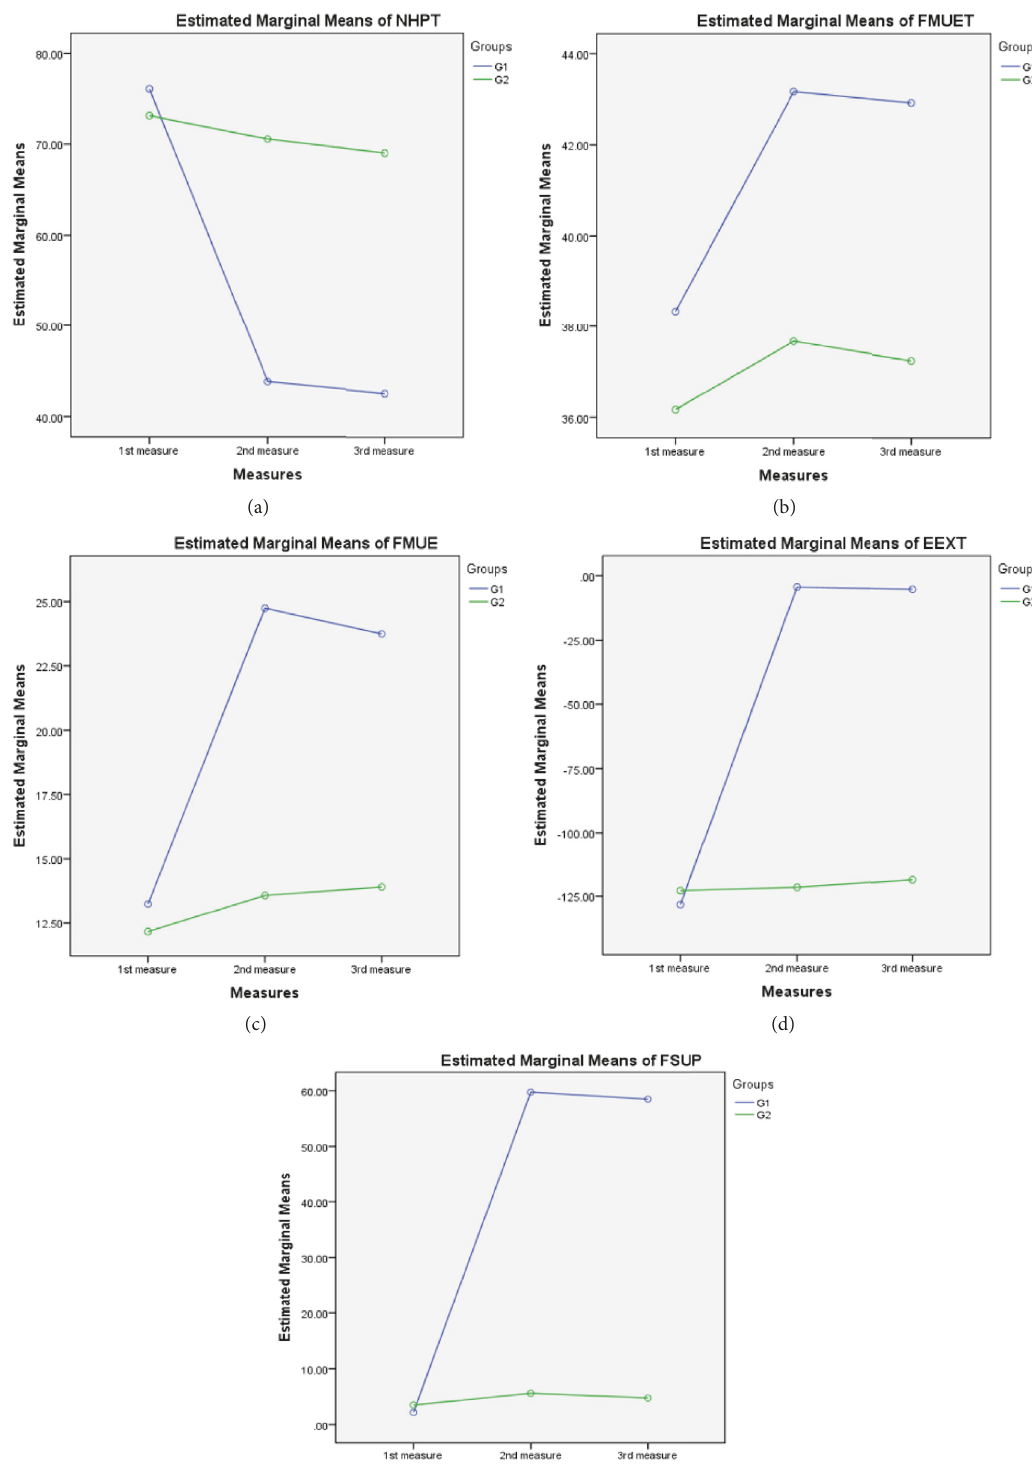
Figure 2: The plot of the mean of (a) Nine-Hole Peg Test (NHPT), (b) total upper extremity Fugl-Meyer tFMUL), (c) FMUL, (d) elbow extension (EEXT), and (e) forearm supination (FSUP) ROMs score for treatment applied on each group and measurements are plotted in a line